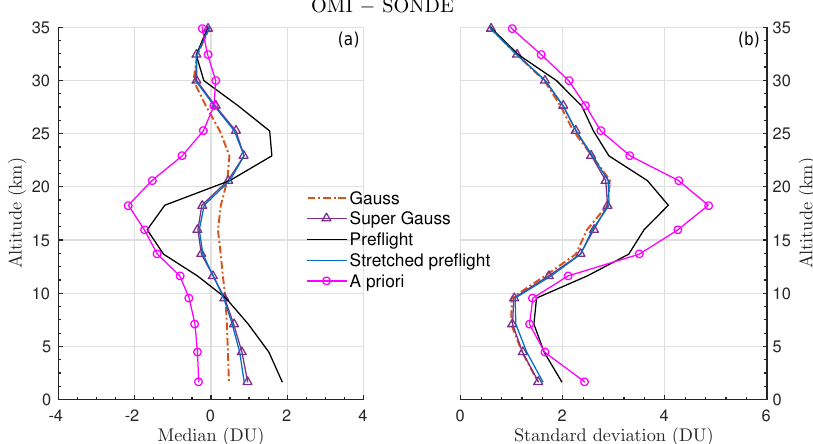
Figure 10. (a) Median biases of OMI profiles retrieved using four different slit functions compared to the ozonesondes. The median difference between a priori profile and the ozonesonde data is also shown. (b) Standard deviation of the differences between different retrievals and ozonesonde data. The a priori error is shown in (b)